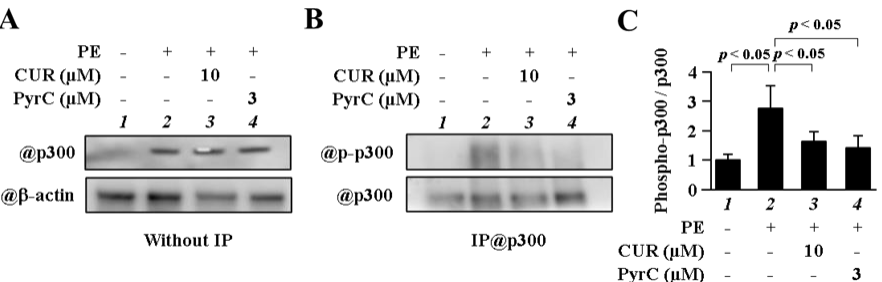
Figure 6. Phosphorylation of p300 was inhibited by PyrC in cardiomyocytes. ( A – C ) Nuclear proteins were extracted from primary cardiomyocytes after 48 h of PE stimulation. ( B ) Photograph of a representative IP-WB. ( C ) Quantifications of ( B ). N = 3.